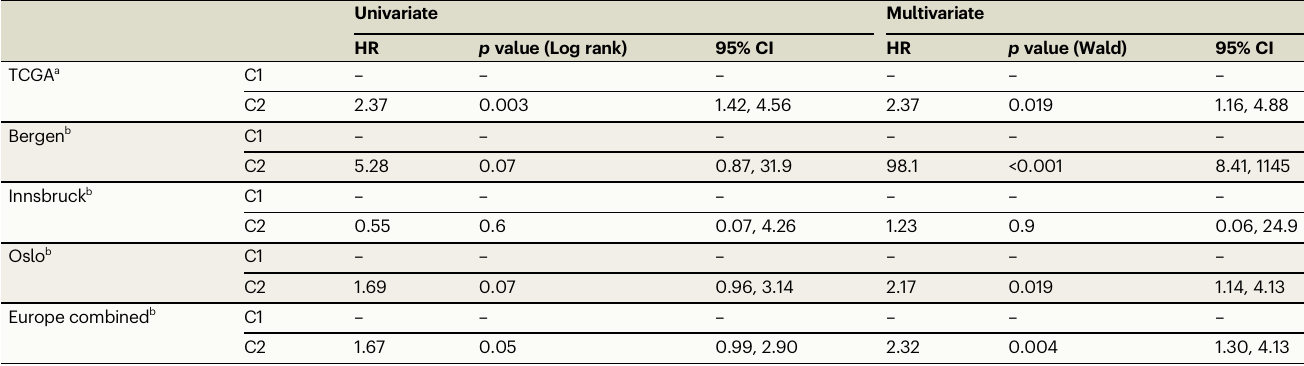
Table 2 | Overall (TCGA) and disease-speci fi c (individual and combined European cohorts) survival